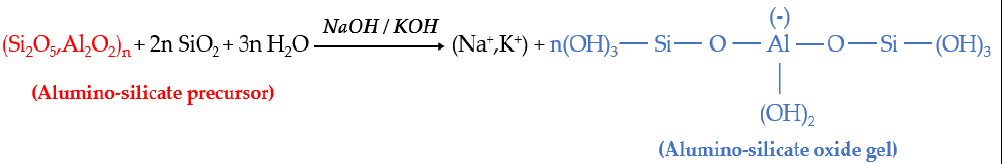
Figure 3. Dissolution and hydrolysis reaction of the alumino-silicate Figure 2. Dissolution and hydrolysis reaction of the alumino-silicate precursor.